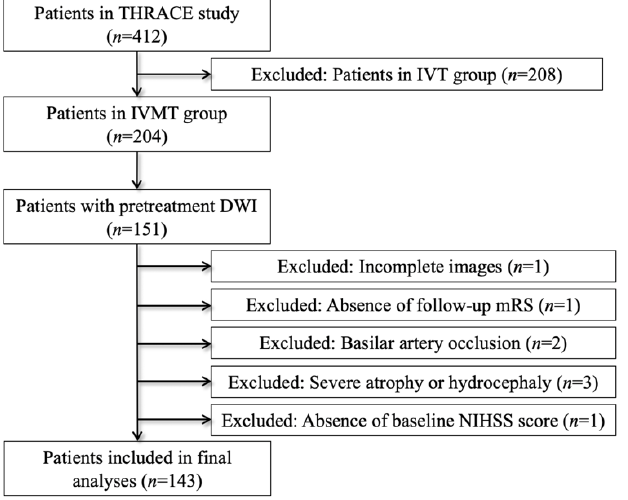
Figure 2. Patient selection flowchart. Abbreviations: IVT = intravenous thrombolysis; IVTMT = in- travenous thrombolysis plus mechanical thrombectomy; DWI = diffusion-weighted imaging; mRS = modified Rankin Scale.